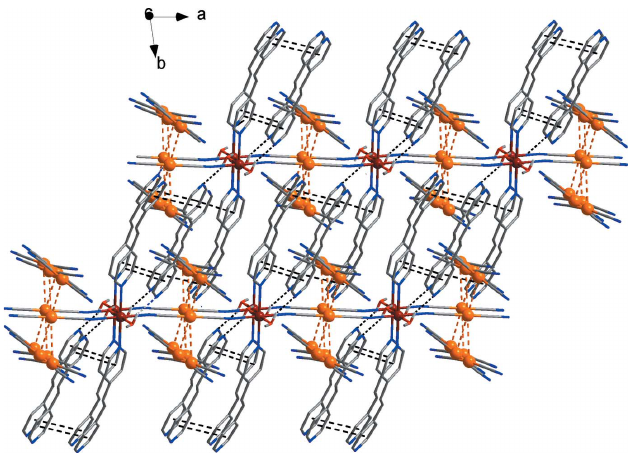
Figure 2 A view along the c axis of the crystal packing of the title compound. (cid:2) – (cid:2) contacts and hydrogen bonds are shown as black dashed lines. Aurophilic interactions are shown as orange dashed lines. Guest water molecules are omitted for